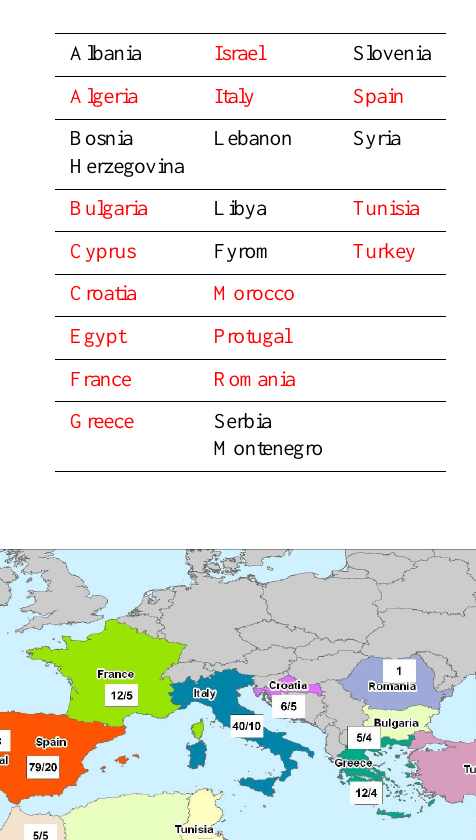
Table 1. List of Mediterranean countries with those participating in the MEDEX project shown in red. The preliminary analysis of this paper was conducted on the basis of these latter countries.